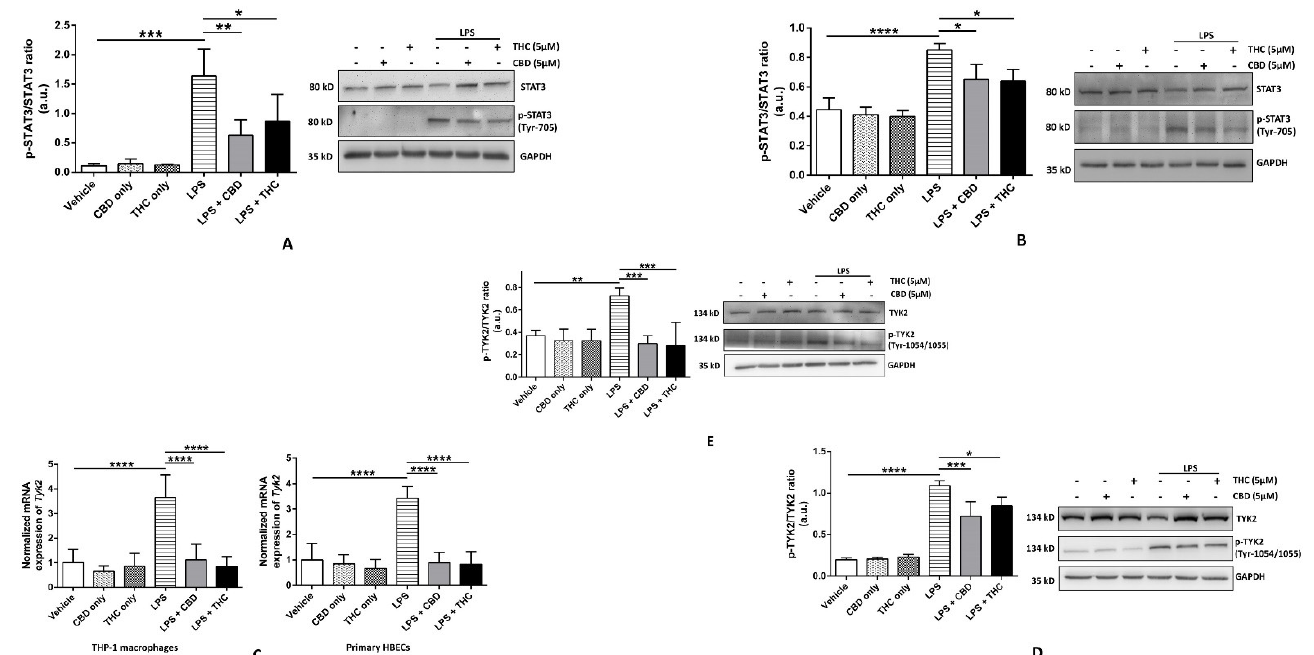
Figure 6. Effect of cannabinoids on TYK-2-mediated phosphorylation of STAT3 in THP-1 macro- phages and primary human bronchial epithelial cells. ( A ): CBD and THC decreased the ratio of the expressions of phospho-STAT3 (Tyr-705)/STAT3 after LPS stimulation in THP-1 macrophages: Rep- resentative Western blots of p-STAT3, STAT3, and GAPDH bands and the quantification of the ratio p-STAT3/STAT3 using one-way ANOVA with Tukey’s multiple-comparison test. Four independent experiments ( n = 4) of primary human bronchial epithelial cell lysates obtained after pre-treatment with CBD or THC for 30 min and LPS stimulation for 3 h were analyzed, and data are expressed as means ± SD; * p < 0.05, ** p < 0.01, *** p < 0.001. ( B ): CBD and THC decreased ratio of the expressions of phospho-STAT3 (Tyr-705)/STAT3 after LPS stimulation in primary HBECs: Representative Western blots of p-STAT3, STAT3, and GAPDH bands and the quantification of the ratio p-STAT3/STAT3 using one-way ANOVA with Tukey’s multiple-comparison test. Four independent experiments ( n = 4) of THP-1 cell lysates obtained after pre-treatment with CBD or THC for 30 min and LPS stimulation for 8 h were analyzed, and data are expressed as means ± SD; * p < 0.05, **** p < 0.0001. (Abbreviation: HBECs: Human bronchial epithelial cells). ( C ): CBD and THC decreased the gene expression of Tyk2 after LPS stimulation in THP-1 macrophages and primary HBECs: The mRNA expression of Tyk2 relative to GAPDH normalized to vehicle was quantified using one-way ANOVA with Tukey’s multiple-comparison test. Four independent experiments ( n = 4) using total RNA isolated from THP-1 and primary bronchial epithelial cells obtained after by pre-treatment with CBD or THC for 30 min and LPS stimulation (3 h for THP-1 cells and 8 h for primary HBECs) were analyzed, and data are expressed as means ± SD; **** p < 0.0001. Each independent experiment was run in duplicates. (Abbreviation: HBECs: Human bronchial epithelial cells). ( D ): CBD and THC decreased the ratio of the expressions of phospho-TYK2 (Tyr1054/1055)/TYK2 after LPS stimulation in THP-1 macrophages: Representative Western blots of p-TYK2, TYK2, and GAPDH bands and the quantificationof the